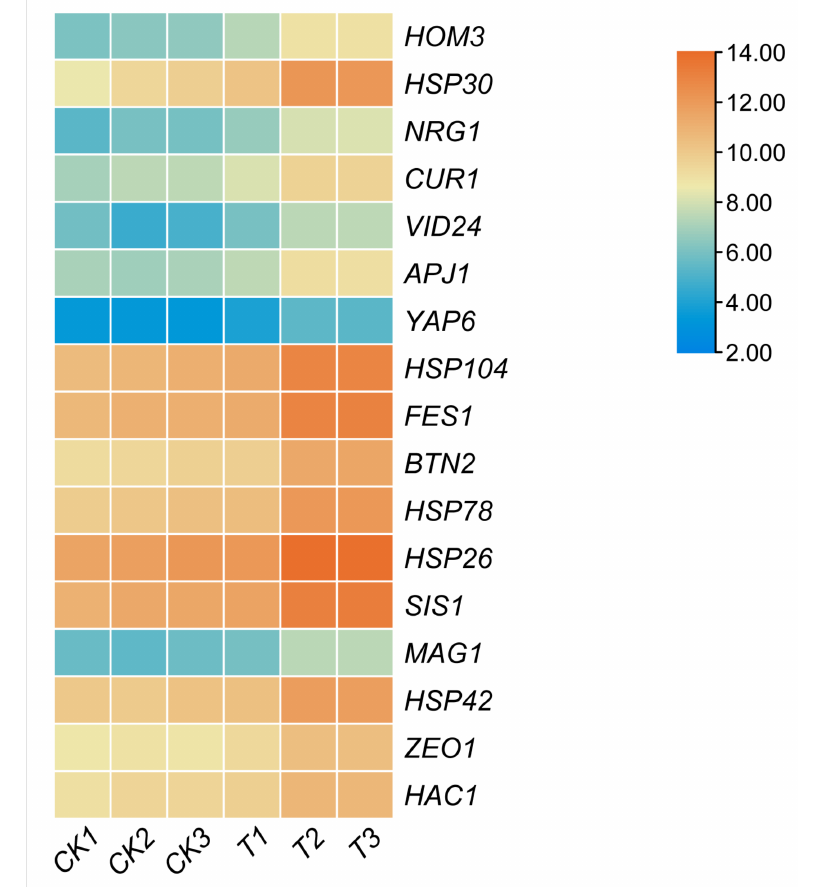
Figure 4. Heat map of the expression levels of differentially expressed, stress-related genes. Color represents expression change. CK1, CK2, and CK3, control; T1, T2, and T3, A9- MET4, treated in a sulfite-containing medium for 10